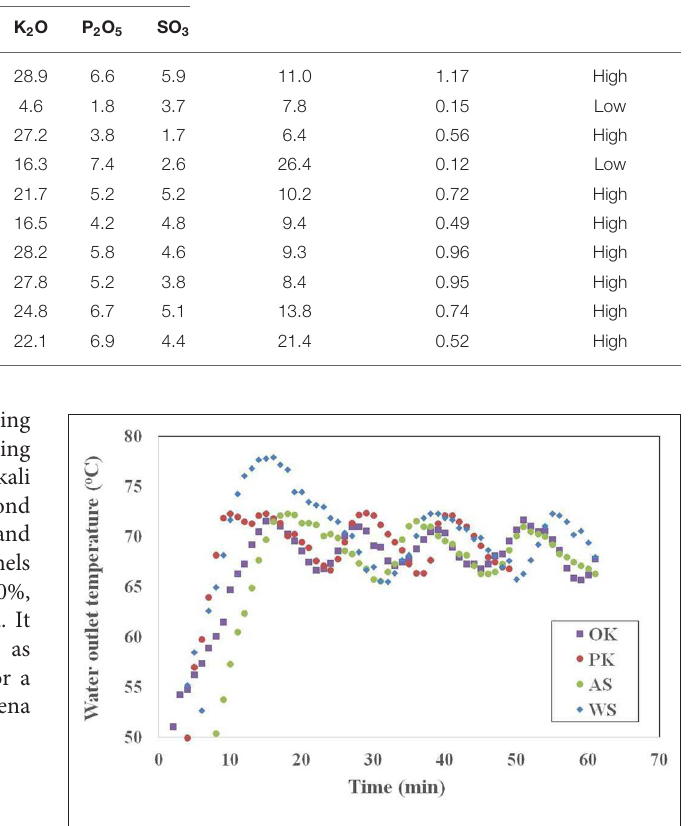
FIGURE 2 | Evolution of boiler water outlet temperature for raw fuels during full operation of the